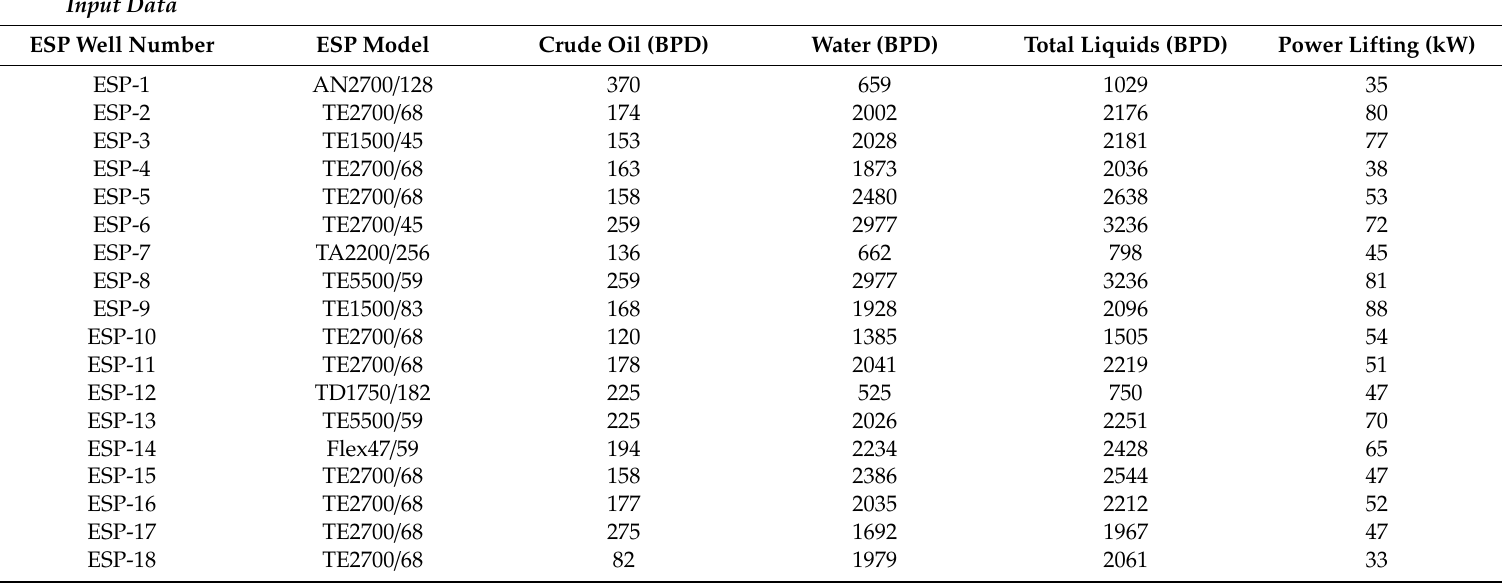
Table A1. Input data for well level EROI, EI, and fuel